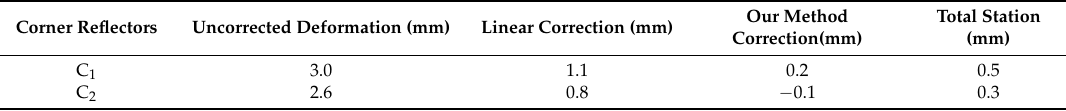
Table 2. Comparison of results.